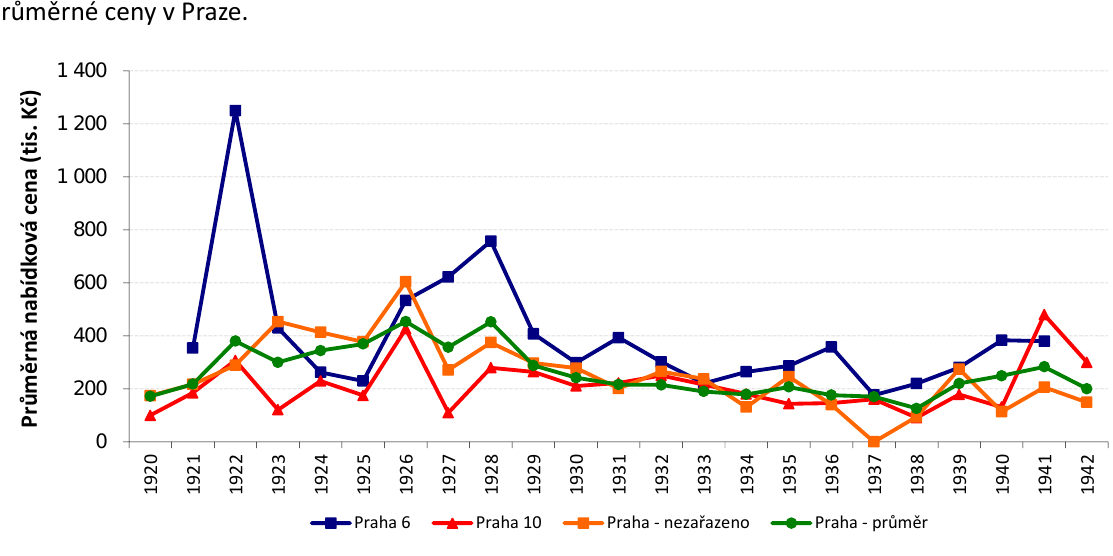
Vývoj cen bytového domu pro region